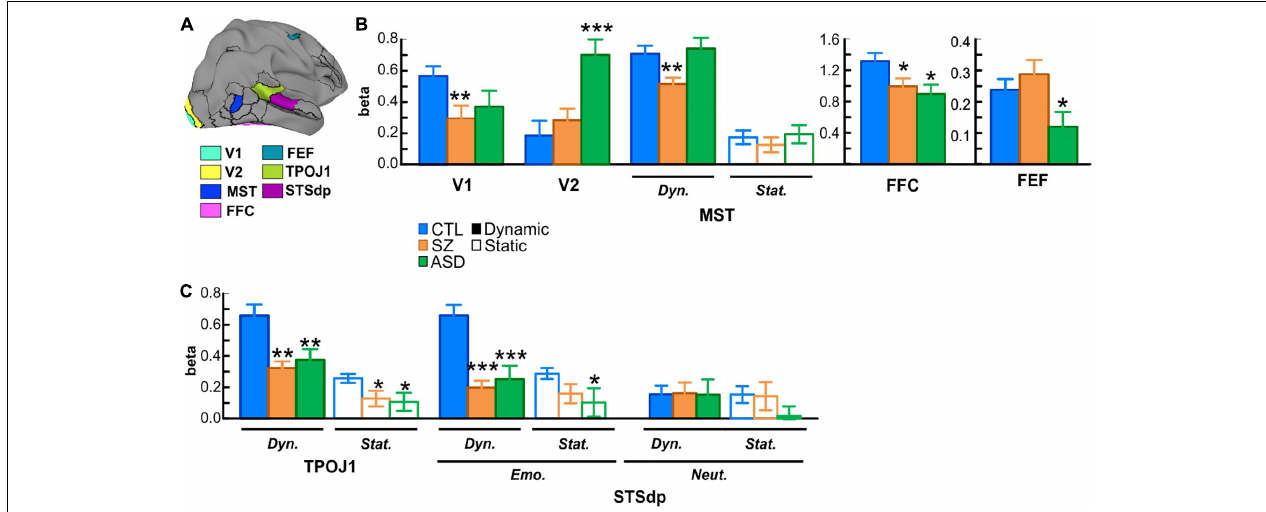
FIGURE 3 | (A) Localization of key parcels with overall group differences: early visual areas V1 and V2; medial superior temporal cortex (MST); fusiform face complex (FFC); frontal eye fields (FEF); temporo-parietal junction (TPOJ1); and dorsal posterior superior temporal sulcus (STSdp). (B) Mean activation (beta parameter) extracted from each key parcel for the control (CTL; blue bars), schizophrenia (SZ; orange bars), and autism (ASD; green bars) groups. In parcels with a face-motion effect, activation to dynamic (solid bars) and static (open bars) faces are plotted separately. Asterisks indicate a significant difference in SZ or ASD groups relative to CTL. (C) Activation in the STS parcels (TPOJ1, STSdp) showing differential activation patterns for dynamic/static, emotional (Emo.)/neutral (Neut.) faces in